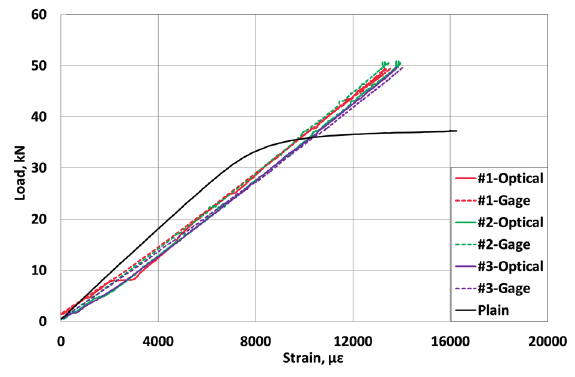
Figure 7. Load-strain curves of the core wire specimens of the